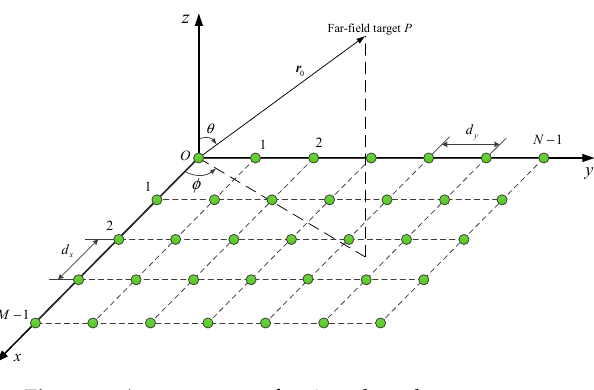
Figure 1. Arrangement of active phased antenna array.